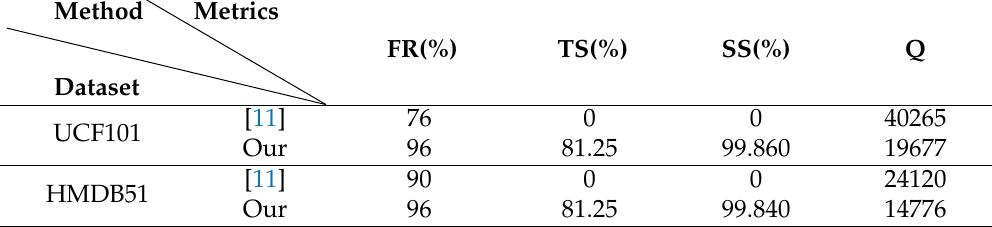
Table 5. Results of LRCN model with UCF101 and HMDB51 datasets in black-box setting.